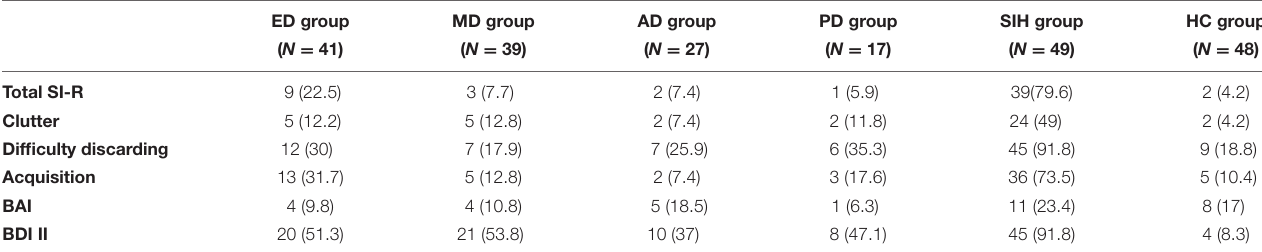
TABLE 3 | Number and (percentages) of individuals in the six groups assessed scoring above the cut-off